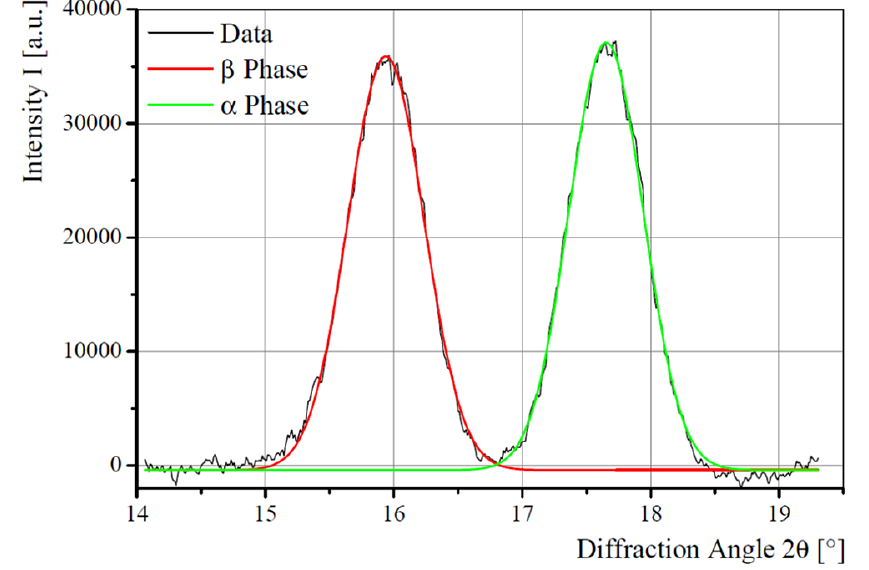
Figure 8. Gauss fits to bicomponent fiber WAXD data. The analyzed intensity distributions are for the (001)β and